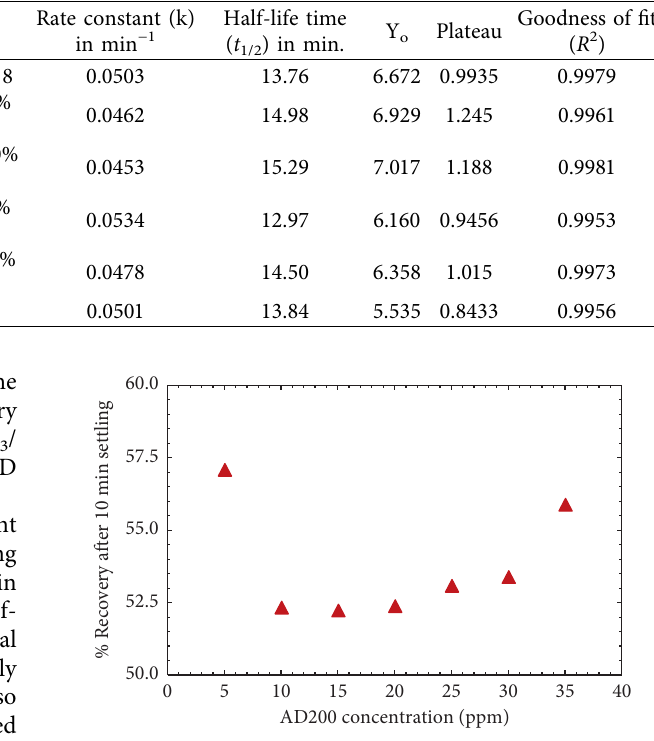
Figure 7: Recovery of concentrate from 25 wt. % slurry of slime at different doses of AD 200 at pH